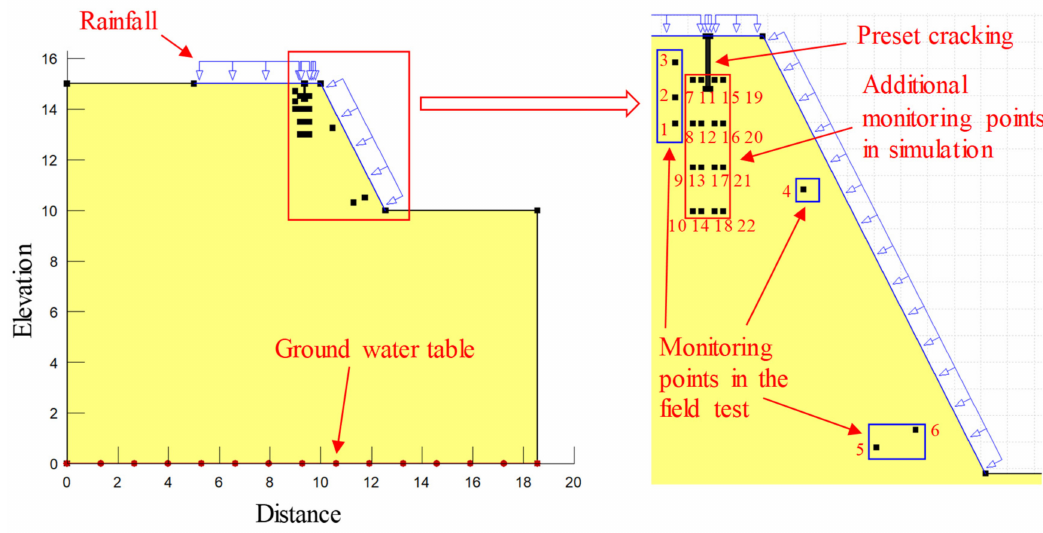
Figure 11. Monitoring points of numerical models under simulated